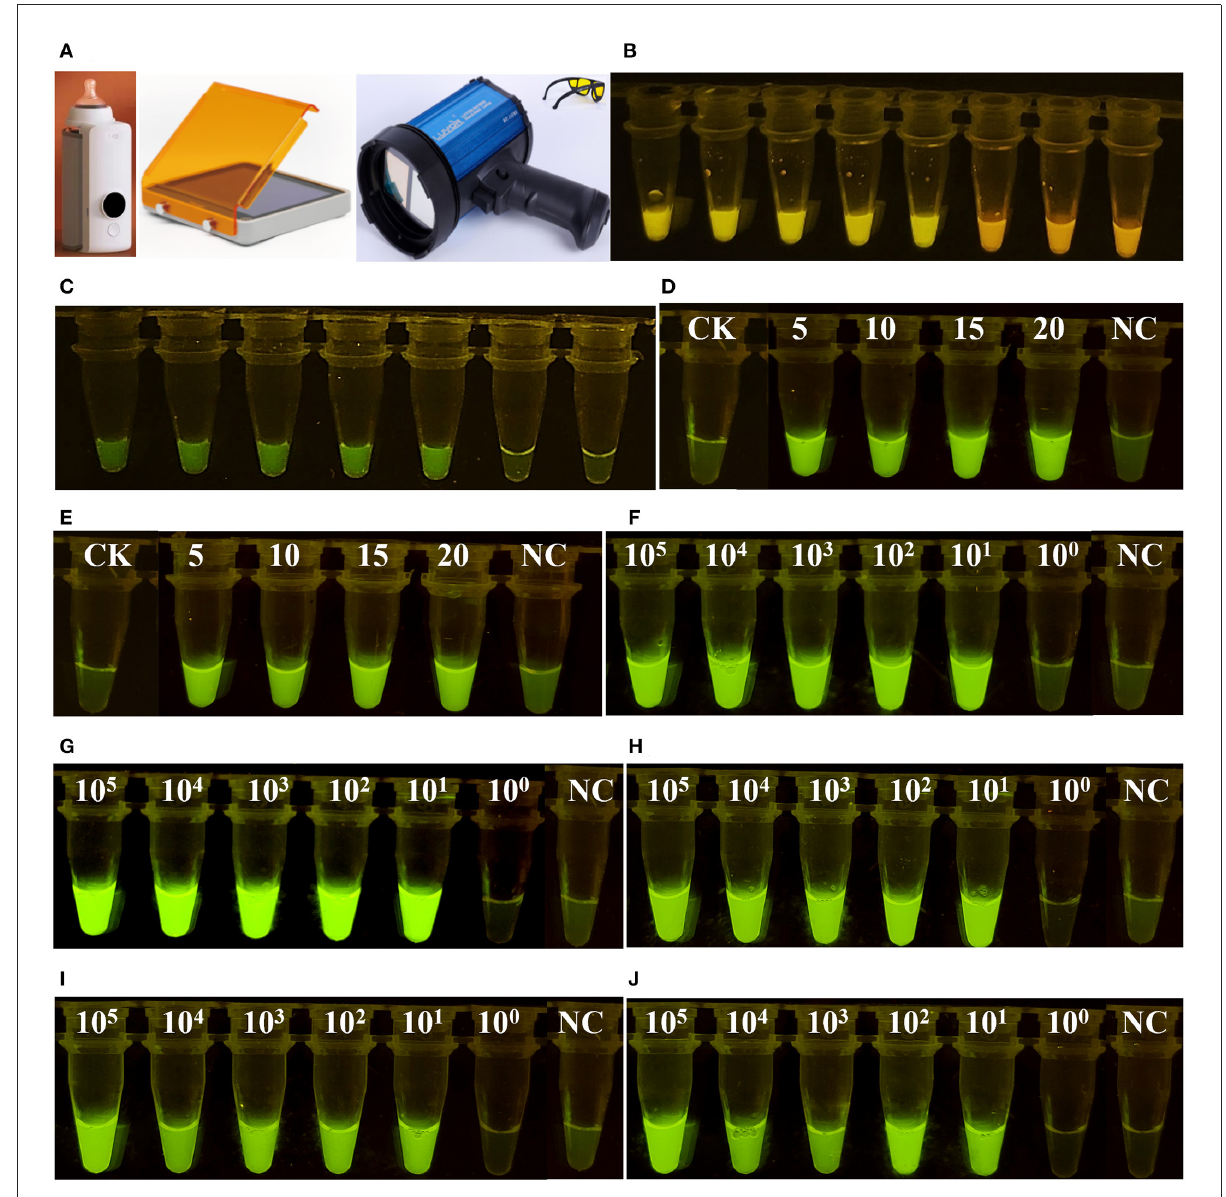
FIGURE4 Visual detection of fluorescent signals. (A) Portable devices for heating and detecting fluorescence. (B) Visual detection of ssDNA probe 1. (C) Visual detection of ssDNA probe 2. (D) Optimization of the volume ratio of RPA and Cas12a. A total of 20 µ l of Cas12a reagent combined with 5–20 µ l of RPA reagent was employed. (E) The samples were processed for 12h and then observed. (F–J) show six concentrations of Bel-1 , Bel-2 , Bel-3 , Bel-4, and Bel-5 ,